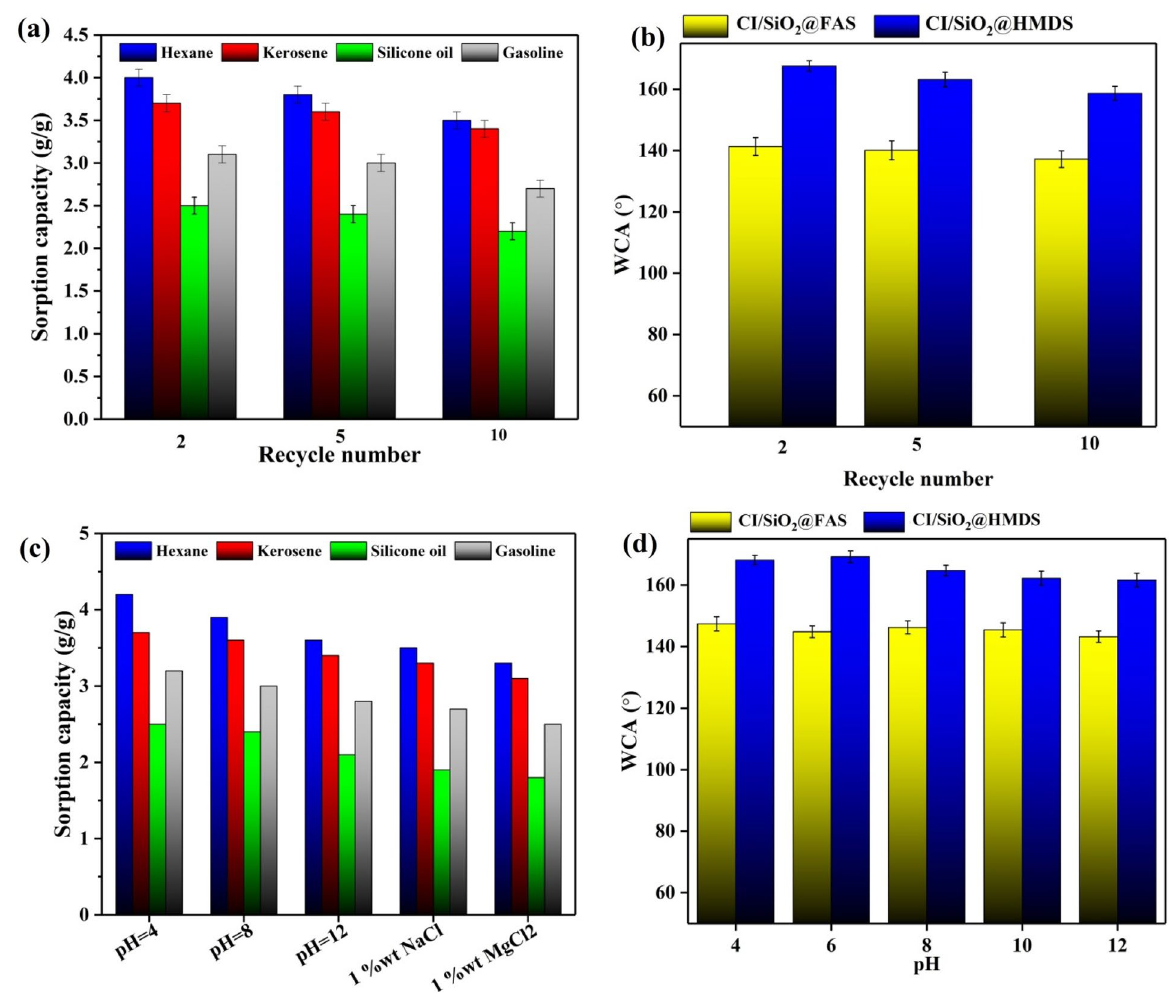
Figure 9. ( a ) Recyclability of the CI/SiO 2 @HDMS in different regeneration cycles, ( b ) water contact angle variations in different cycles, ( c ) the performance of CI/SiO 2 @HDMS for sorption oils under various circumstances, and ( d ) water contact angle variations for immersion at different pH values for one